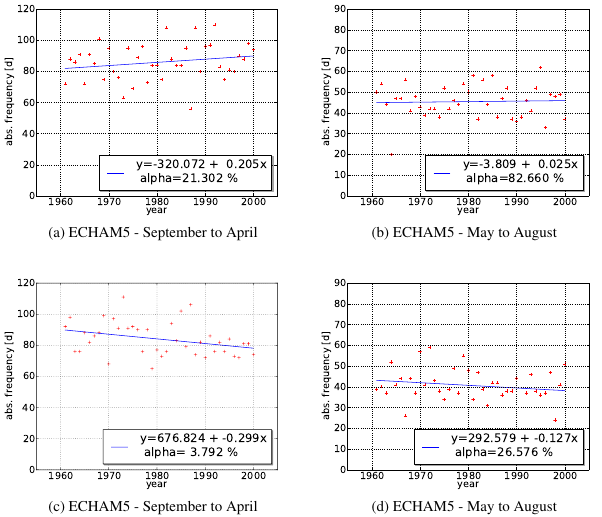
34 Fig. 9. Trends in the frequency of anticyclonic (CP2,CP3, CP5 and CP8 – first line) and cyclonic CPs (CP7, CP10, CP11 and CP12 – second line) according to the 20th-century run of ECHAM5 during two seasons.